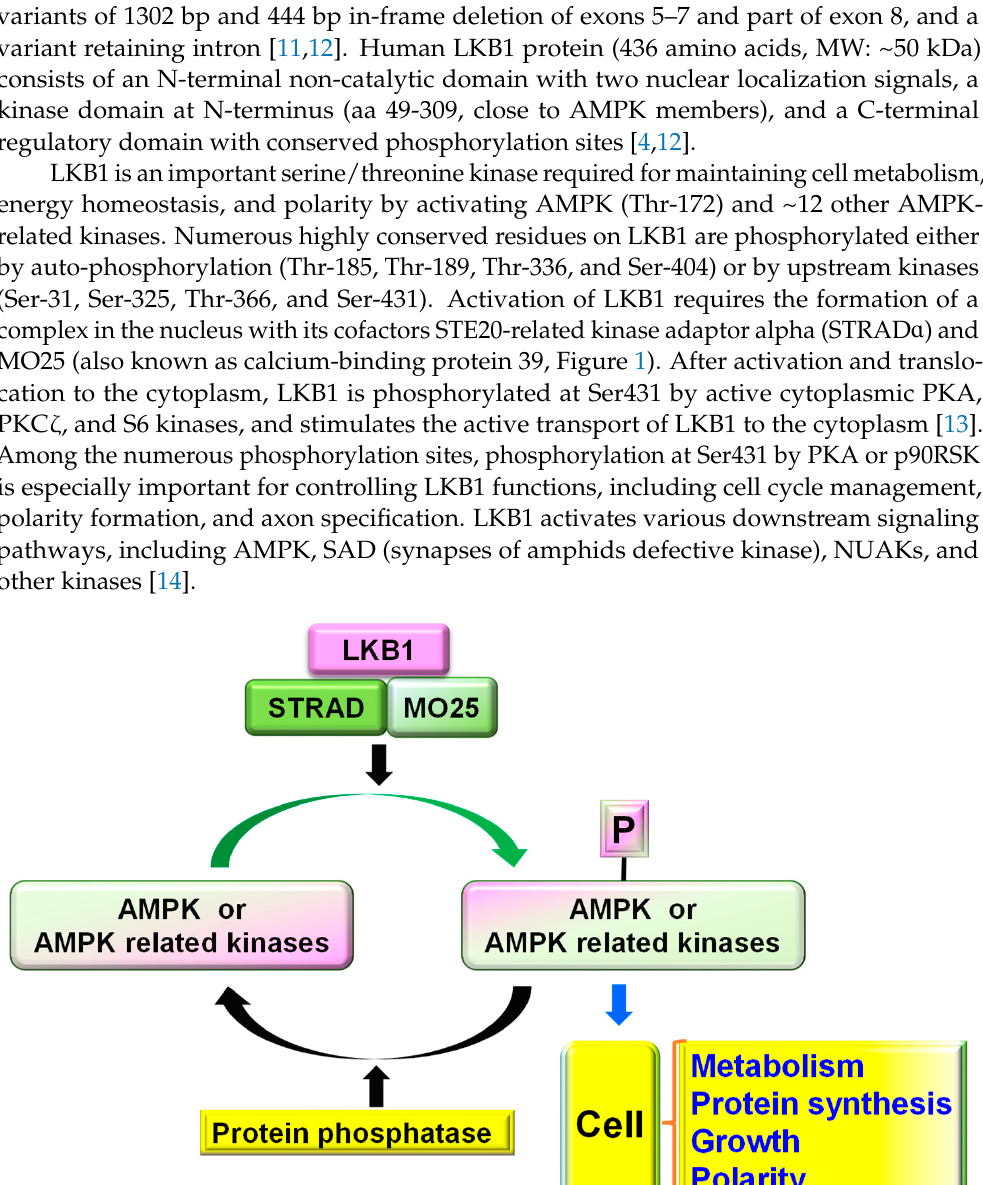
Figure 1. Schematic of LKB1–STRAD–MO25 complex and its major functions. LKB1–STRAD–MO25 complex phosphorylates AMPK and AMPK-related kinases, which can be dephosphorylated by protein phosphatases. Increased phosphorylation of AMPK and its related kinases controls various cellular functions, including cell energy metabolism, protein synthesis, growth, and polarity.